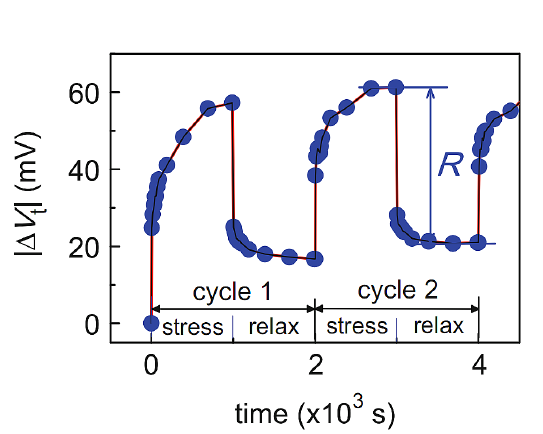
Figure 2. Absolute change of the threshold voltage due to electrical stress and further reduction once in the recovery phase ([4], p. 291).